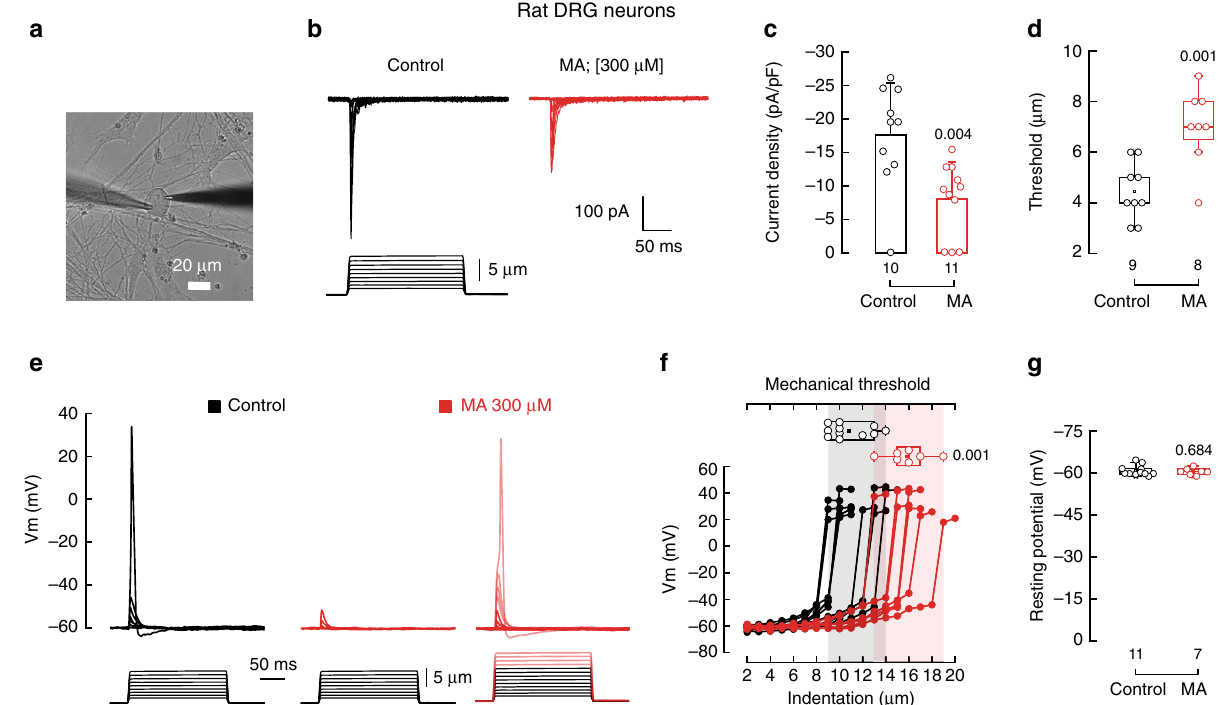
Fig. 5 MA decreases mechano-activated currents in rat DRG neurons. a Micrograph showing a rat DRG neuron in the whole-cell patch-clamp con fi guration ready for mechanical stimulation. Micrograph is representative of at least 12 independent preparations. b Representative whole-cell patch- clamp traces of mechanically activated currents of control and MA (300 μ M)-treated rat DRG neurons. c Current densities elicited by maximum displacement of control and MA (300 µ M)-treated rat DRG neurons. Bars are mean ± SD. n is denoted above the x -axis. Two-tailed unpaired t -test. d Boxplots show mean, median, and the 75 th to 25 th percentiles of the displacement thresholds required to elicit currents of control and MA (300 μ M)- treated rat DRG neurons. n is denoted above the x -axis. Two-tailed unpaired t -test. e Representative current-clamp recordings of membrane potential changes elicited by mechanical stimulation in control and MA (300 µ M)-treated rat DRG neurons (up to 9 and 13 µ m indentation, respectively). f Membrane potential peak vs. mechanical indentation of independent control (black; n = 11) and MA-treated (red; n = 7) rat DRG neurons. Top panel shows the displacement threshold required to elicit an action potential in these neurons. Boxplots show mean (square), median (bisecting line), bounds of box (75 th to 25 th percentiles), outlier range with 1.5 coef fi cient (whiskers), and minimum and maximum data points. Two-tailed Mann – Whitney test. g Membrane resting potential values recorded brie fl y after whole-cell current-clamp con fi guration was achieved from control and MA (300 µ M)-treated rat DRG neurons. Error bars represent SD. n is denoted above the x -axis. Two-sided permutation t -test. p -values are denoted above the bars and right of the